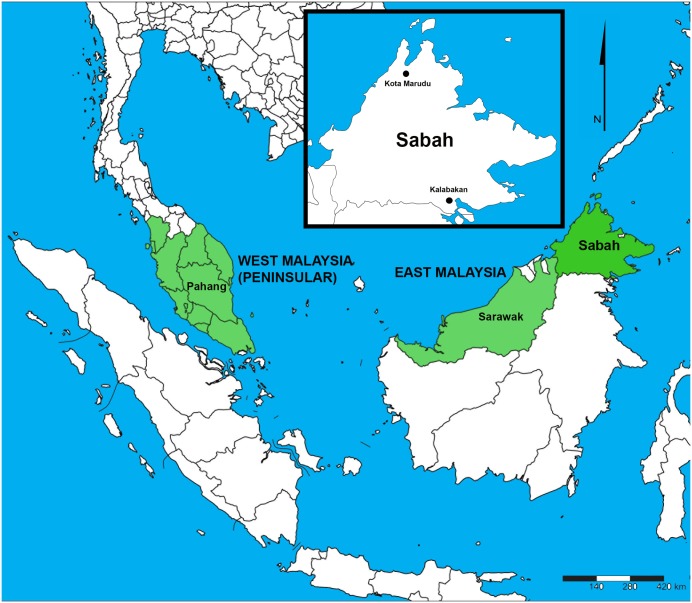
Malaria study areas in Sabah, Malaysia.In the present study, samples were collected from individuals living in two Sabah divisions from Kalabakan district in the Tawau Division and Kota Marudu district in the Kudat Division. This map was generated using SimpleMappr online software [18].